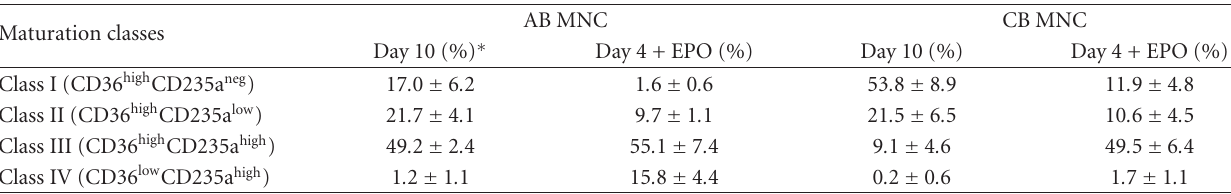
Percentages were calculated with respect to the total cell population present in culture (EBs and non